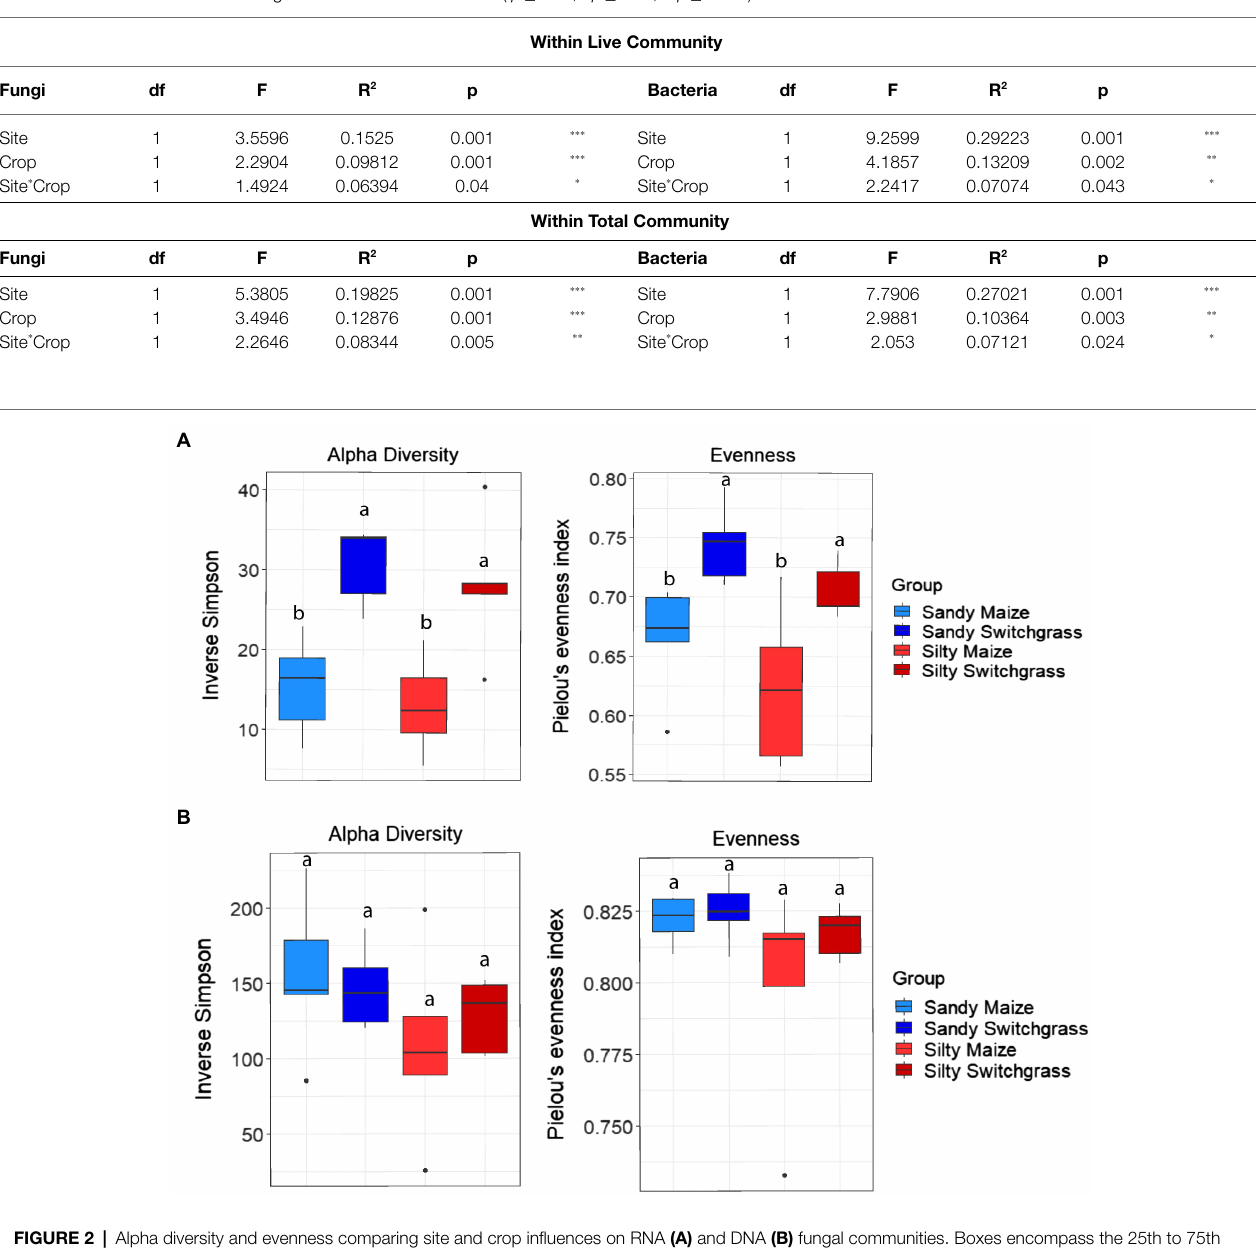
FIGURE 2 | Alpha diversity and evenness comparing site and crop influences on RNA (A) and DNA (B) fungal communities. Boxes encompass the 25th to 75th percentiles and whiskers extend to the maximum and minimum except when a point exceeds 150% of the interquartile range. Black bars indicate the mean and black dots denote outliers. Letters denote significance at p <